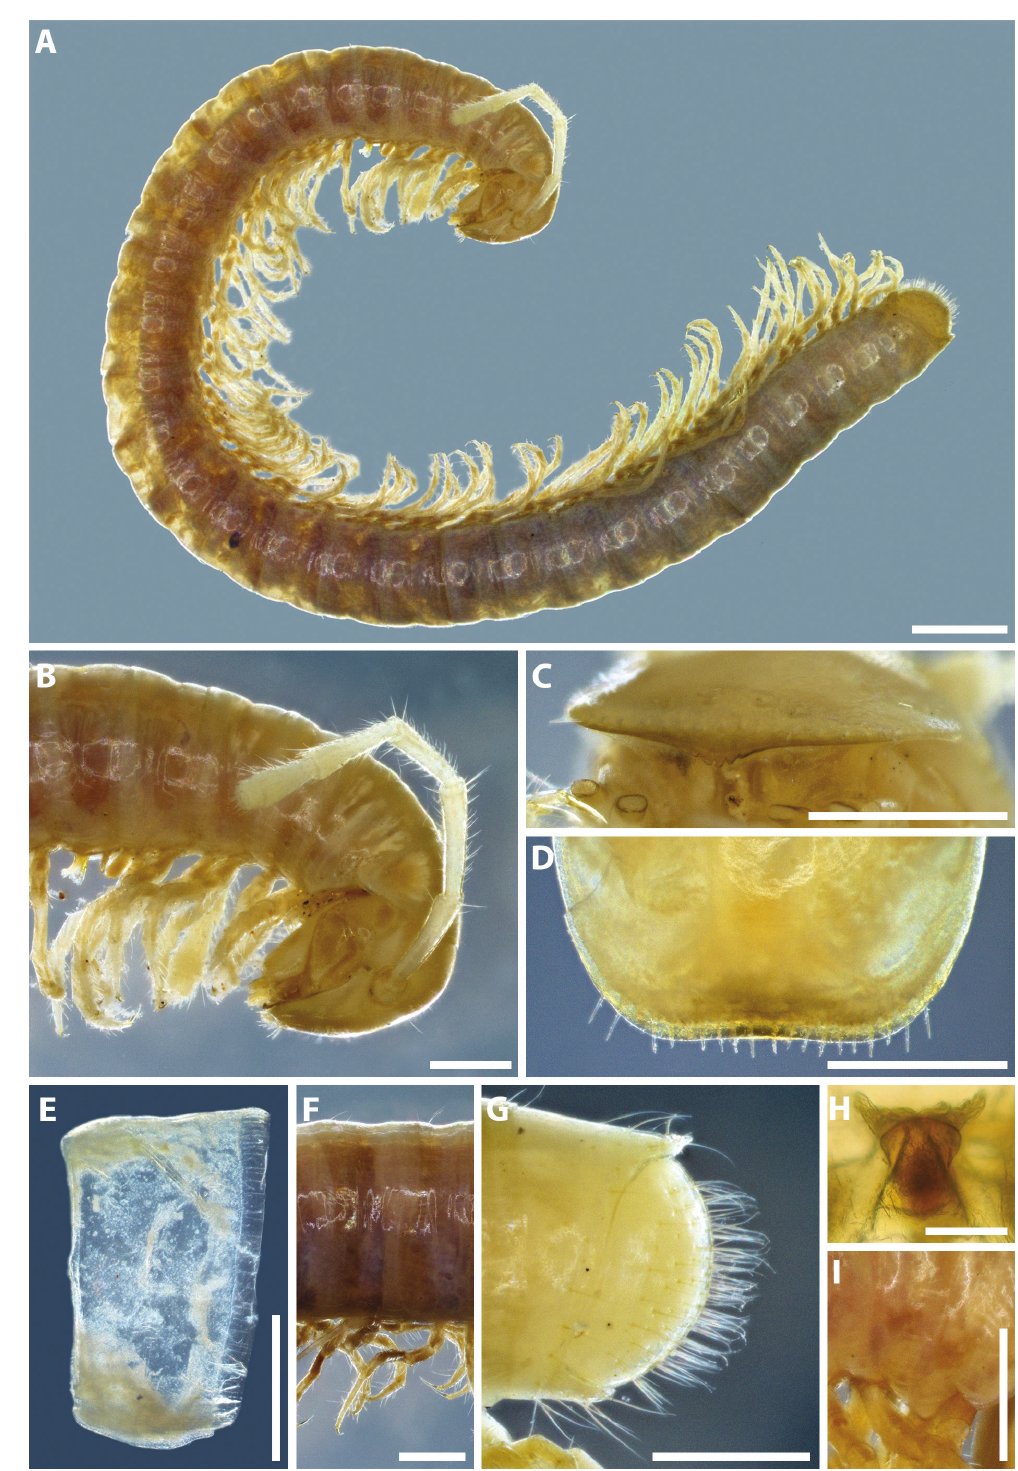
Fig. 4. Stygiiulus gentianae (Strasser, 1971) comb. et stat. nov., ♂ (A–C, E, G) from Grotta [cave] della Vecchia Diga, ♂ topotype (D, H) and ♀ topotype (F, I) (NHMD). A . Habitus, lateral view. B . Anterior part of body, lateral view. C . Labrum, frontal view. D . Labrum, dorsal view. E . Pleurotergum 7, lateral view. F . Mid-body rings, lateral view. G . Telson, lateral view. H . Posterior node of hypopharynx, fronto- ventral view. I . Lobe of body ring 3, lateral view. Scale bars: A = 1 mm; B–G, I = 0.5 mm; H = 0.1